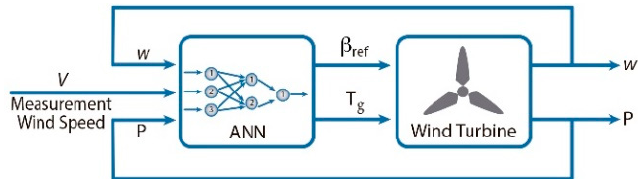
Figure 14. Block diagram of an ANN controller that selects the control signal according to the measured wind speed [71].